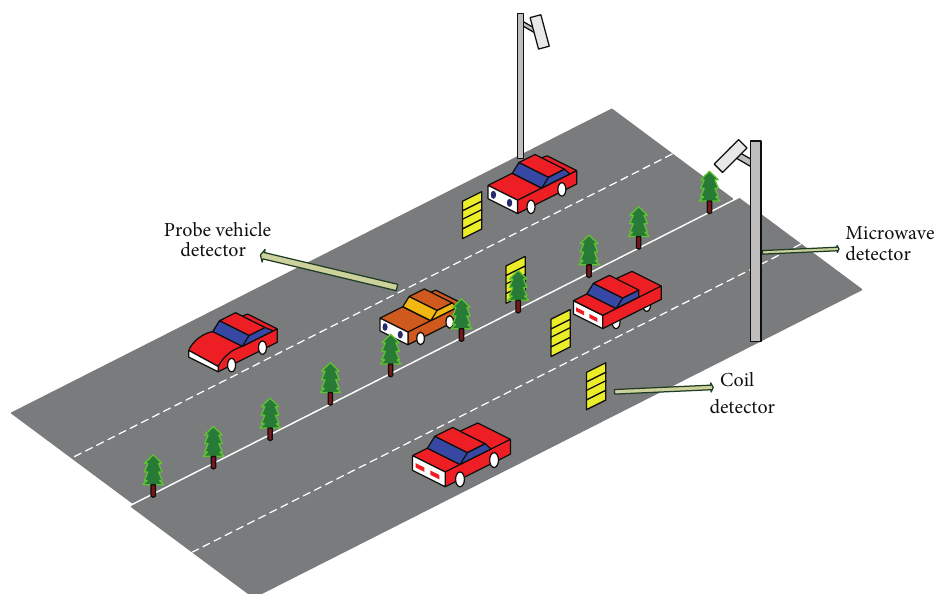
Figure 1: Testing environment of traffic flow data.